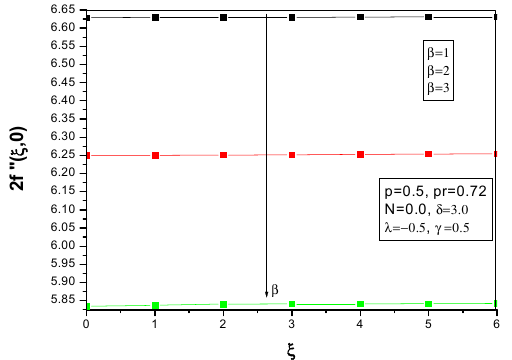
Figure 17. Effect of the magnetic field and buoyancy force parameter on the Nusselt number. Figure 18. Effect of the magnetic field and buoyancy force parameter on the skin friction.